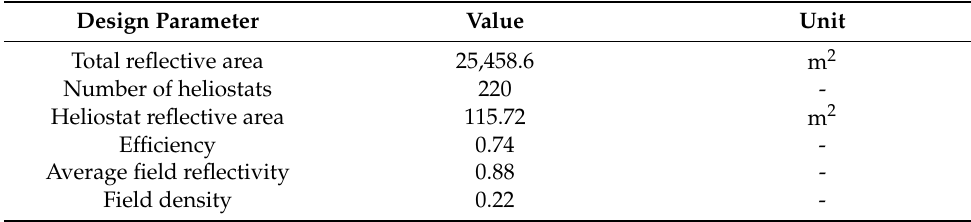
Table 7. Resulting design parameters of the heliostat